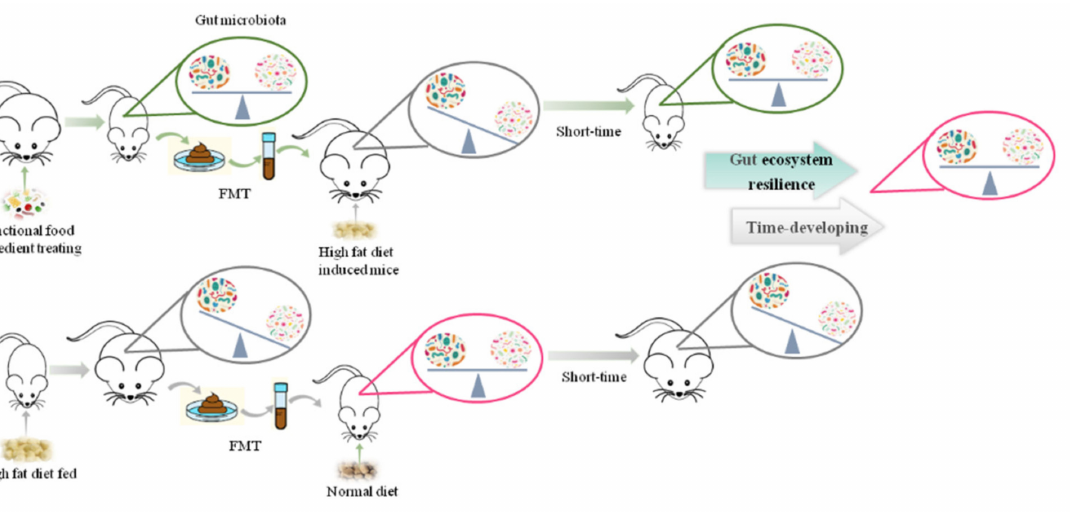
Figure 4. Combined FMT and diet are used and related challenges in obesity research. The green circles in the figure represent the balance of intestinal microbiota regulated by food functional ingredient or FMT. The gray circles in the figure represent the intestinal microbiota disorder in HFD- induced obesity mice. The pink circles in the figure represent the long-term stable gut ecosystem of the individual.